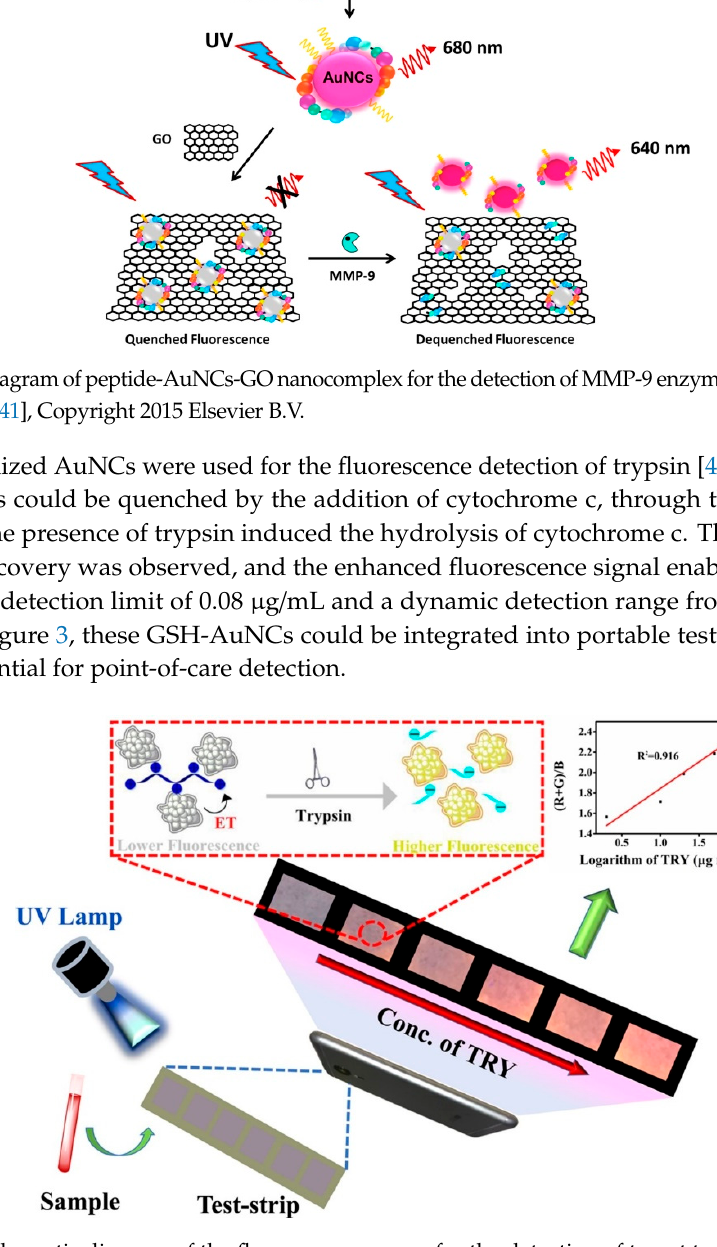
Figure 3. Schematic diagram of the fluorescence sensor for the detection of target trypsin using GSH- stabilized AuNCs. Reprinted with permission [44], Copyright 2018 Elsevier